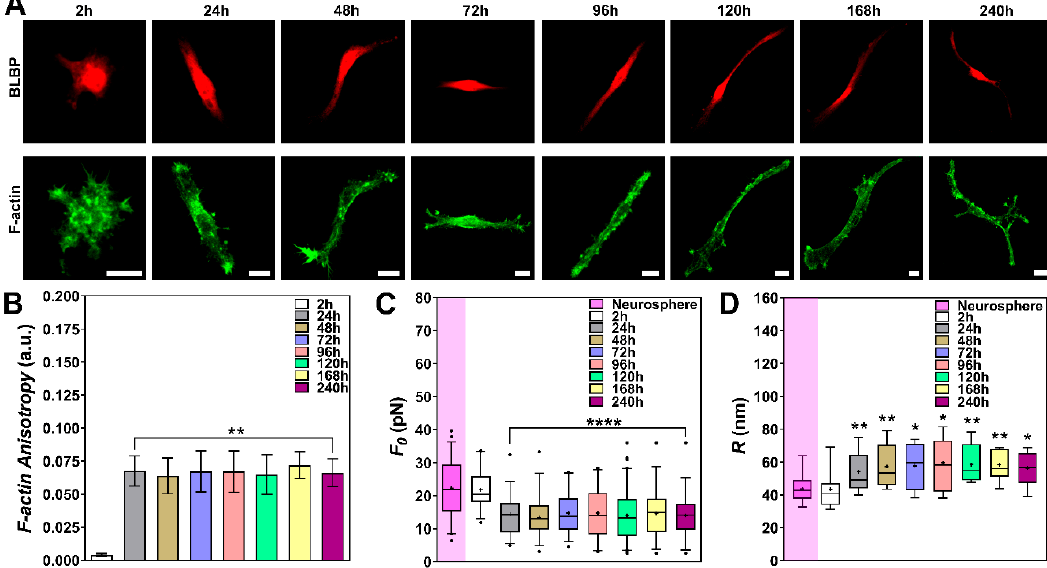
Figure 2. Tether extraction experiments and radius measurements for NPCs. ( A ) Representative images of NPCs stained for BLBP (red) and F-actin, with phalloidin-FITC, (green) from 2 to 240 h. Scale bars are all 10 µ m. ( B ) Plot of the mean anisotropy values of F-actin after FibrilTool analysis. At least 10 di ff erent cells, for each time point, were imaged and analyzed. They all show similar behaviors as the ones represented in A. Standard errors were used as error bars. ( C , D ) Plot of tether force values (at least 32 di ff erent cells) ( C ) and tether radius values (at least 12 di ff erent cells) ( D ) for each experimental group. The colored boxes extend from 25th to 75th percentiles, with a black horizontal line at the median and a black cross at the mean; black whiskers extend from 5th to 95th percentiles; values outside these ranges are plotted as individual points. Tether force and radius values for cells in neurospheres are also represented (highlighted with a purple rectangle) for comparison purposes. * means p < 0.05, ** means p < 0.01, **** means p < 0.0001 in Mann-Whitney U -test statistics when comparing each time point with the 2 h